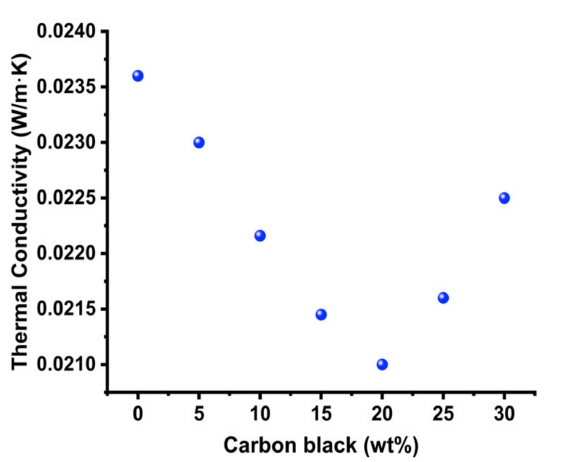
Figure 5. Plot showing how adding different amounts of CB affects the thermal conductivity of hollow silica